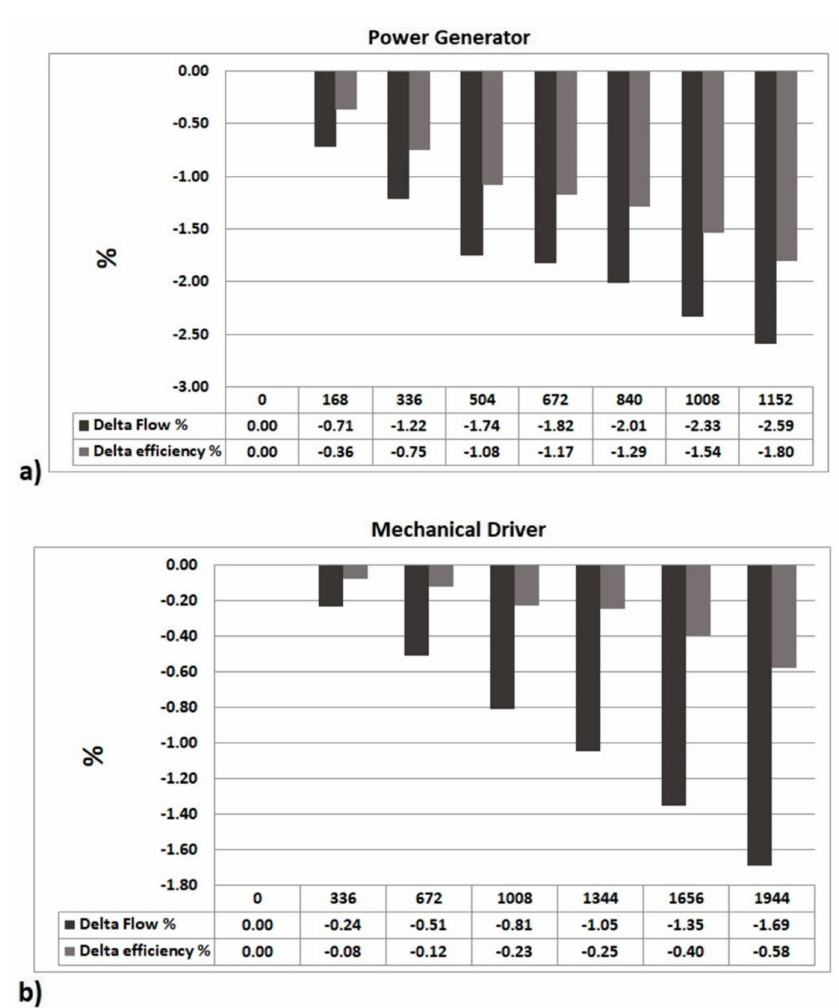
Figure 12. Estimated reduction of compressor discharge air flow and efficiency during fouling conditions: ( a ) power generator; ( b ) mechanical